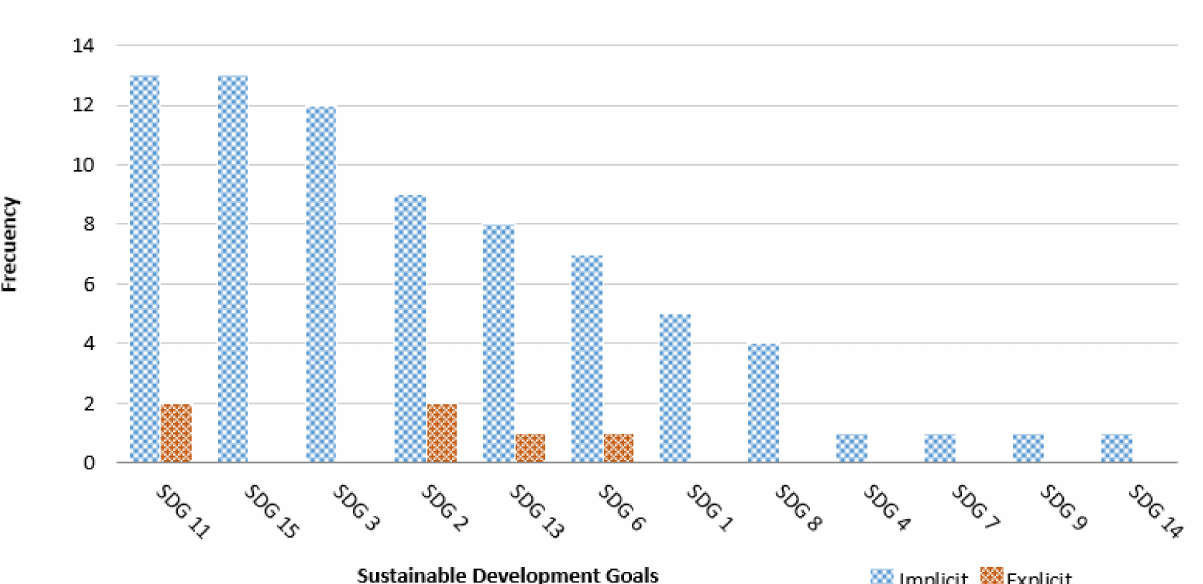
Figure 6. Actors related to the different types and levels of intervention.